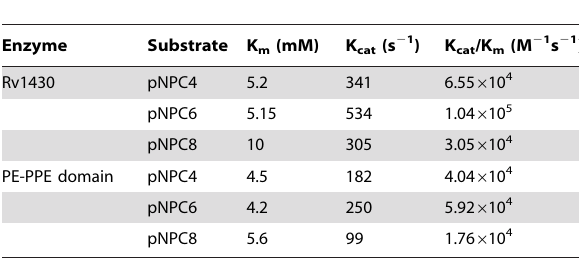
Table 2. The kinetic parameters of Rv1430 and PE-PPE